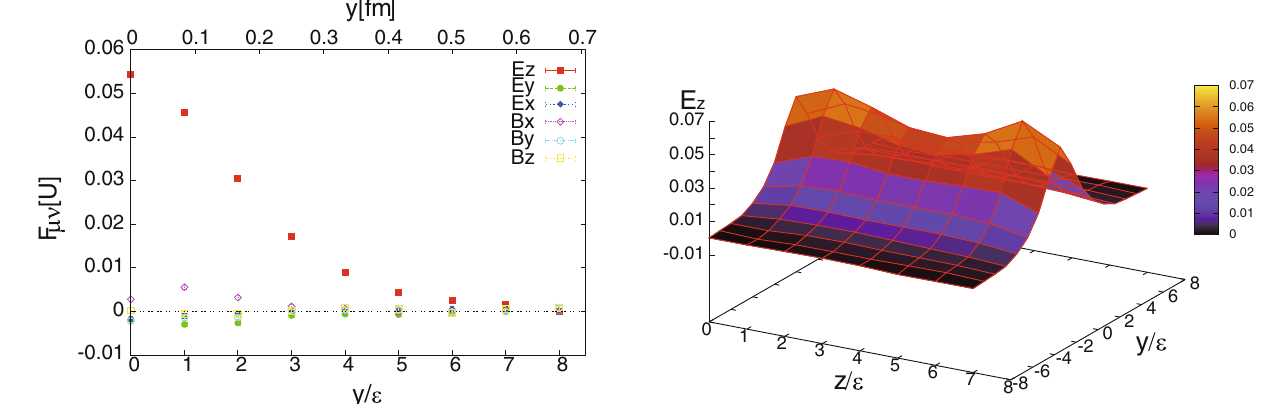
Fig. 2 [17] (Left panel) The gauge-invariant chromofields F μν [ U ] in (3) at the midpoint of the q ¯ q pair ( z = 4) for the 8 × 8 Wilson loop on the 24 4 lattice with the lattice spacing (cid:4) = 0 . 08320 fm at β = 2 . 5 . (Right panel) The distribution of E z [ U ] = F 34 [ U ] in y − z plane